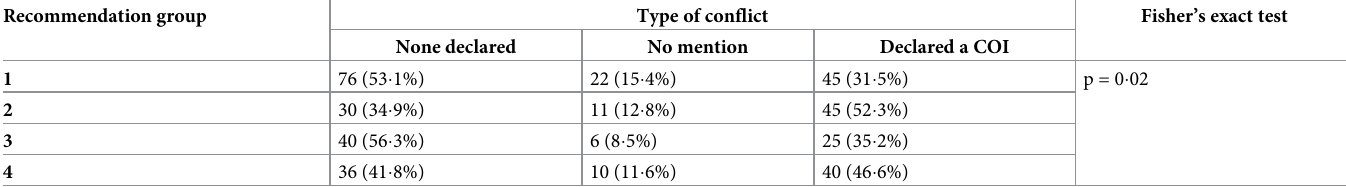
Table 3. Distribution of conflicts of interest per recommendation block and results of the fisher’s exact